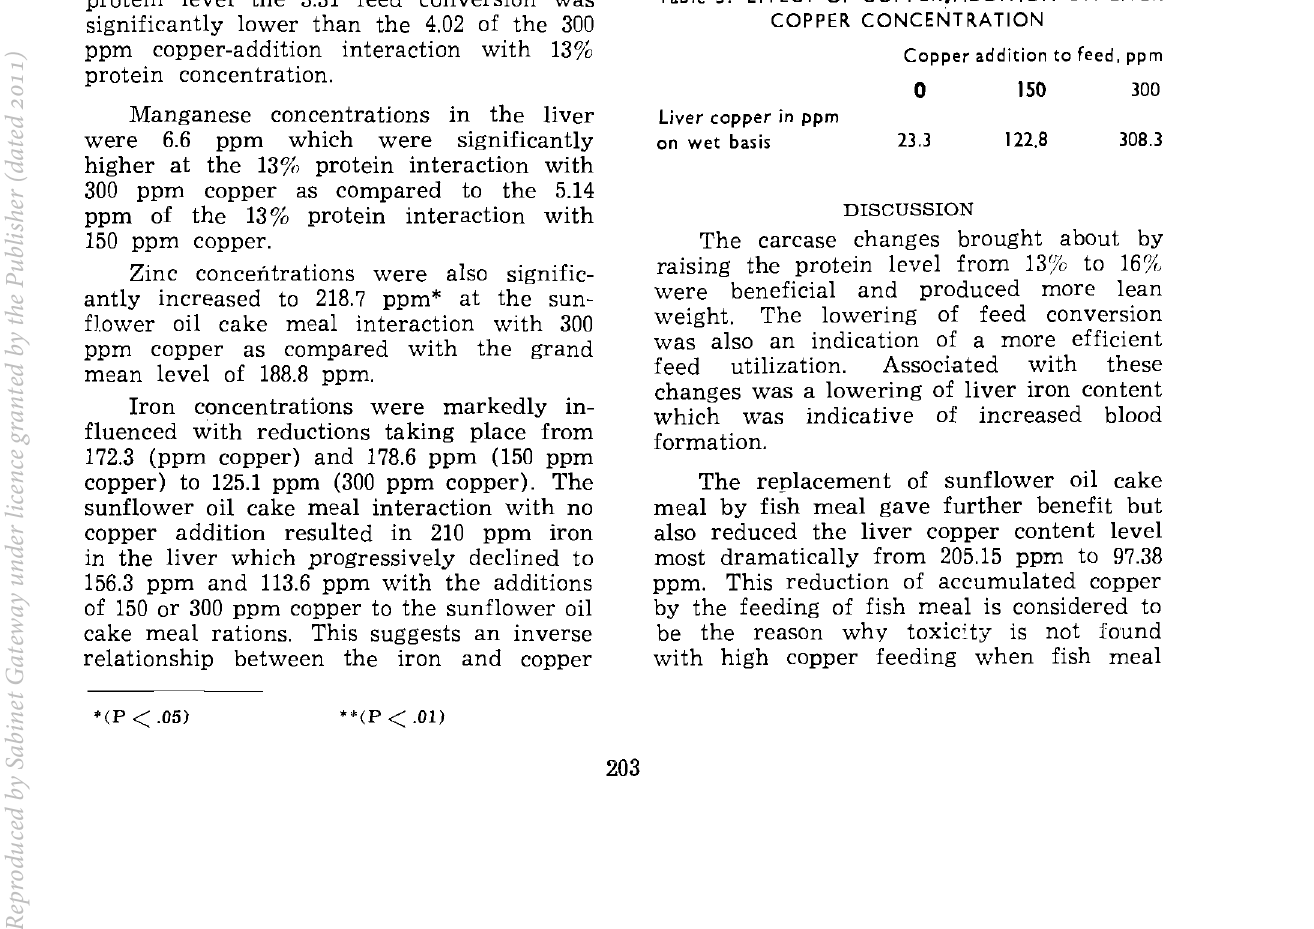
Table 5: EFFECT OF COPPER.ADDITION ON